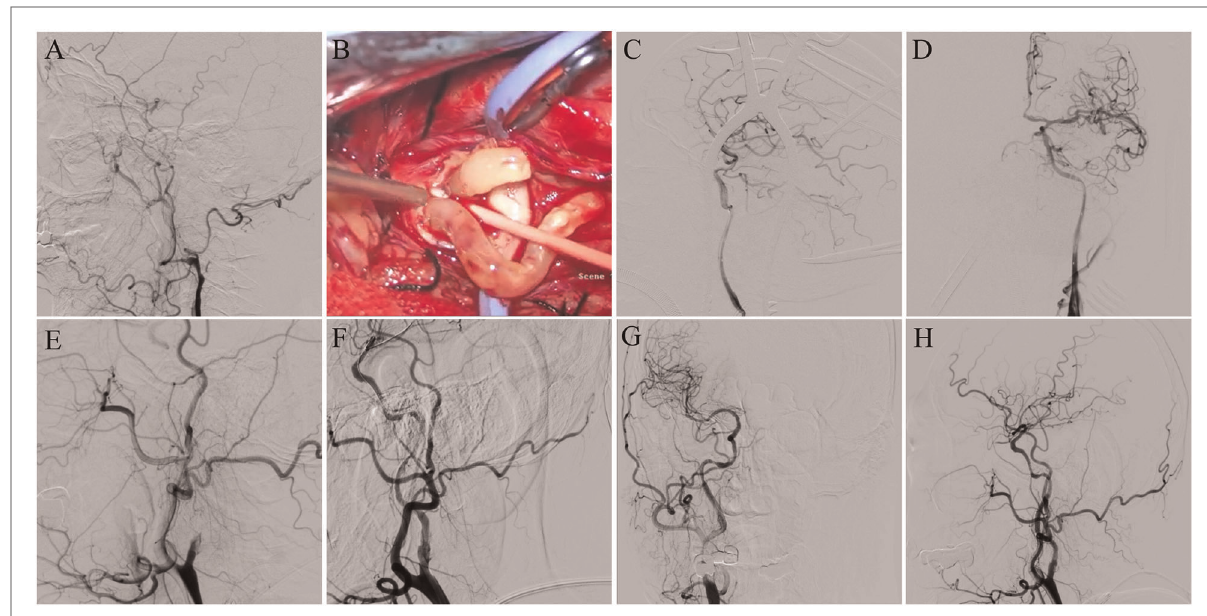
FIGURE 2 Example patients. ( A ) Preoperative digital subtraction angiogram (DSA) reveals a left type C CICAO. ( B ) A 4F Fogarty embolectomy balloon catheter is used to pull out the distal thrombus. ( C ) Microwire is crossed over the lesion, and carotid reconstruction is performed with balloons and stents. ( D ) DSA revealed successful revascularization. ( E ) Preoperative DSA reveals a right type A CICAO. ( F ) The carotid reconstruction is performed from distal to proximal with balloons and stents. ( G,H ) DSA reveals successful